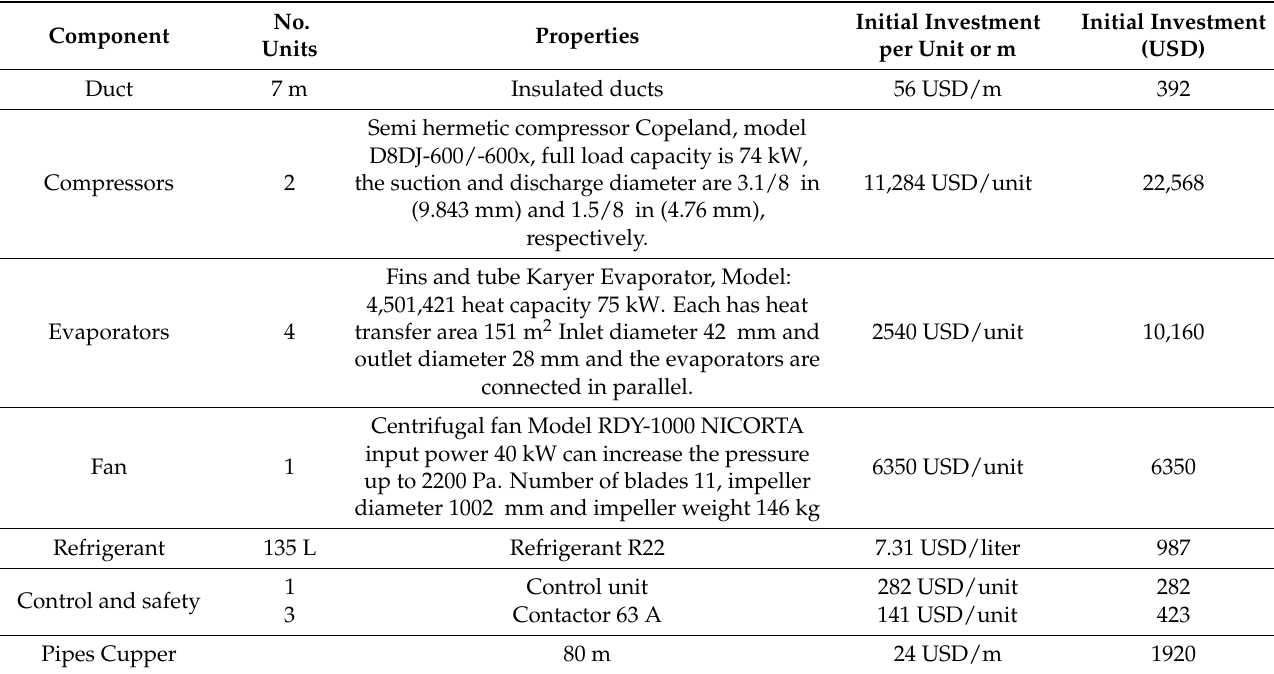
Figure 2. The layout of the refrigeration system setup is designed for a continuous aggregate cooling system. Table 1. Components and capital investment for the air aggregate cooling system.